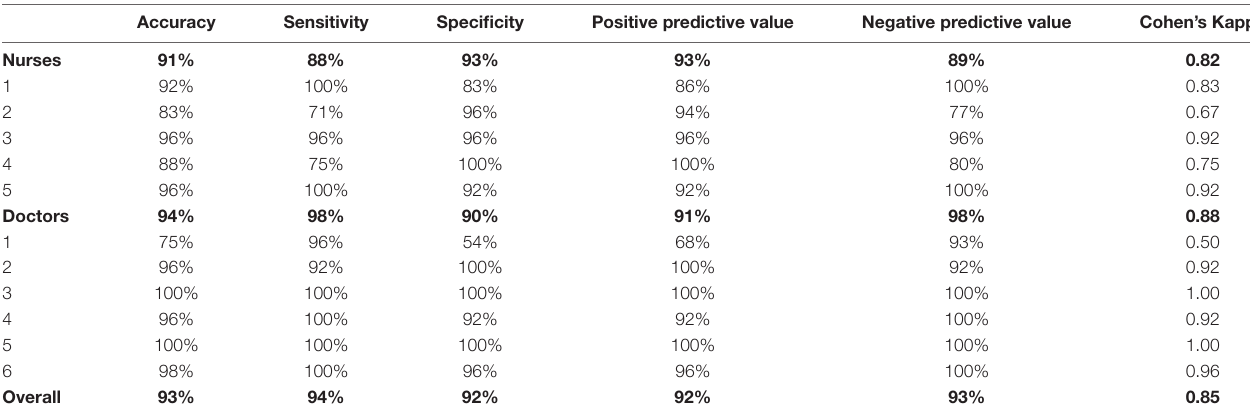
FIGURE 4 | Average pupillary light reflex (PLR) curves overlayed on a single plot for both normal and abnormal subjects. The vertical dashed line in blue represents the timing of the light stimulus for the normal healthy recordings and the vertical dashed line in red represents the slightly differential timing of the light stimulus for the abnormal TBI recordings. TABLE 2 | PupilScreen measures of diagnostic accuracy.